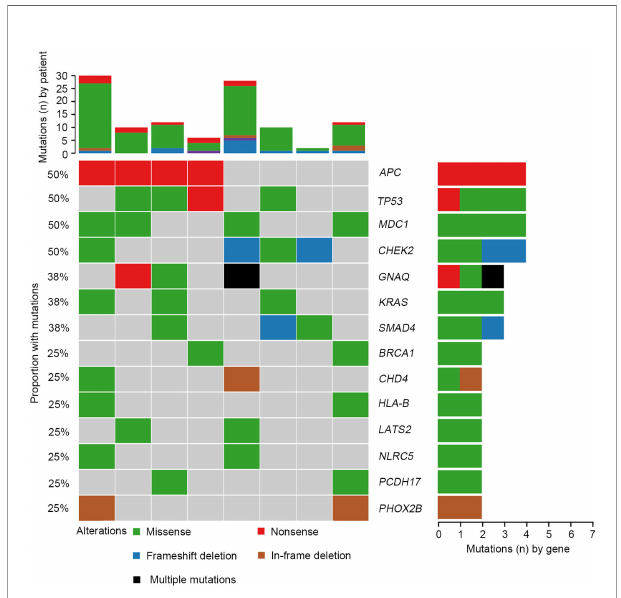
FIGURE 1 | Mutational landscape of colorectal cancer patients with situs inversus totalis (SCRC). Genomic mutations were identi fi ed by targeted NGS of the tumor tissues from patients with SCRC. Multiple mutations, mutations numbers greater than